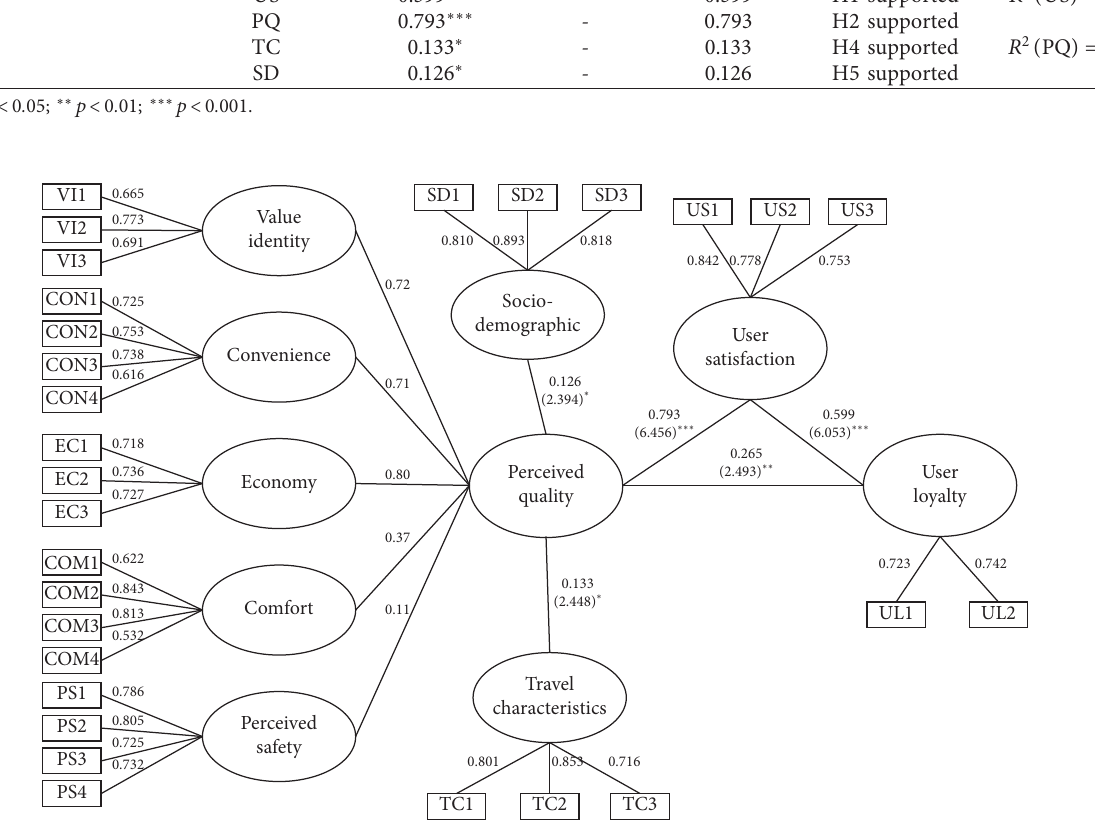
Figure 2: Structural model and standardized weight coefficient. Note. The values represent the standardized regression coefficient β and t values. Table 9: Fit indices of the